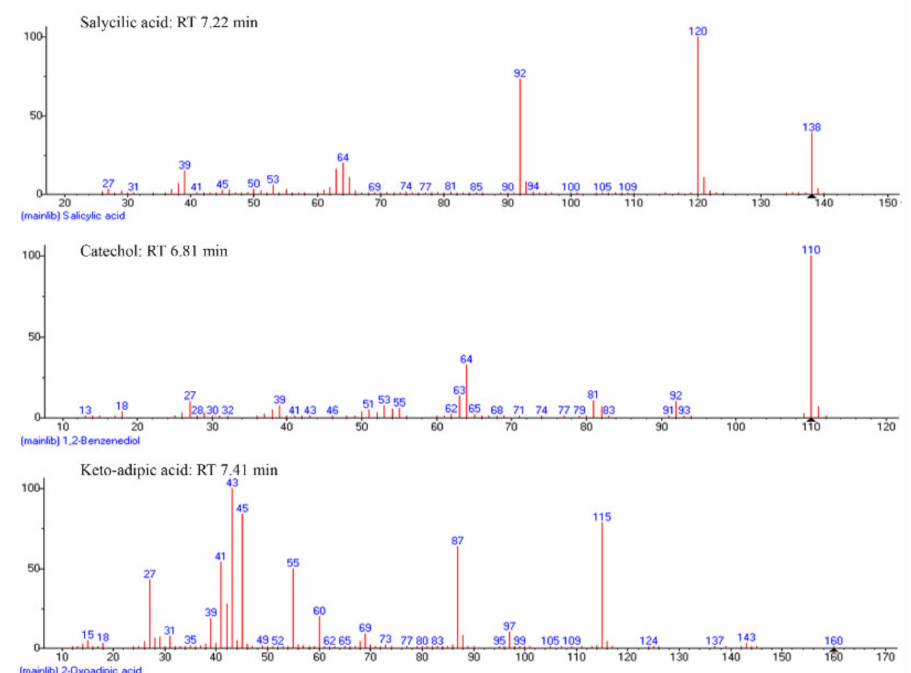
Figure 4. Mass spectral profiles of naphthalene intermediate metabolites.